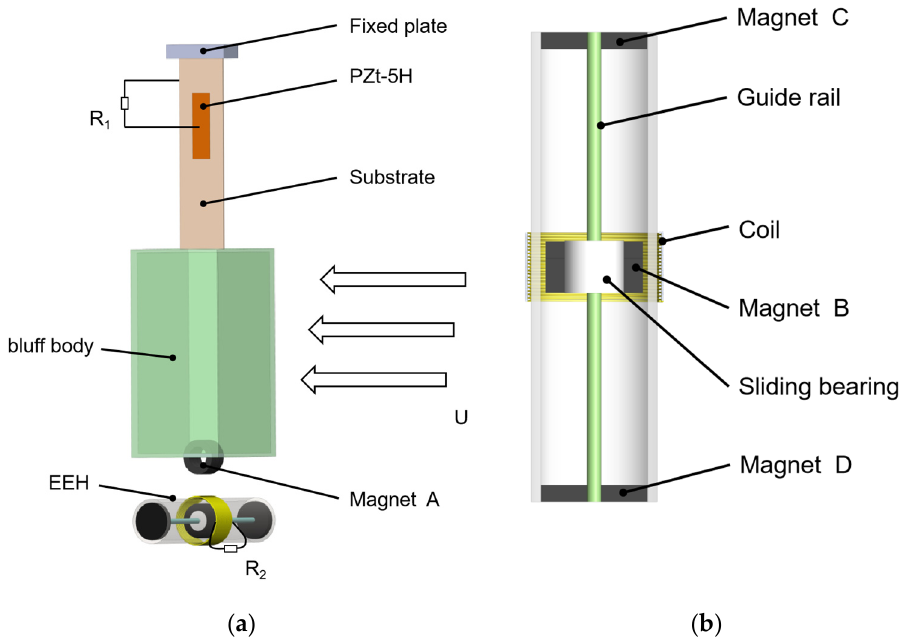
Figure 1. Structural diagram of the MPEGEH: ( a ) The MPEGEH general structure schematic diagram; ( b ) the EEH structure schematic diagram.